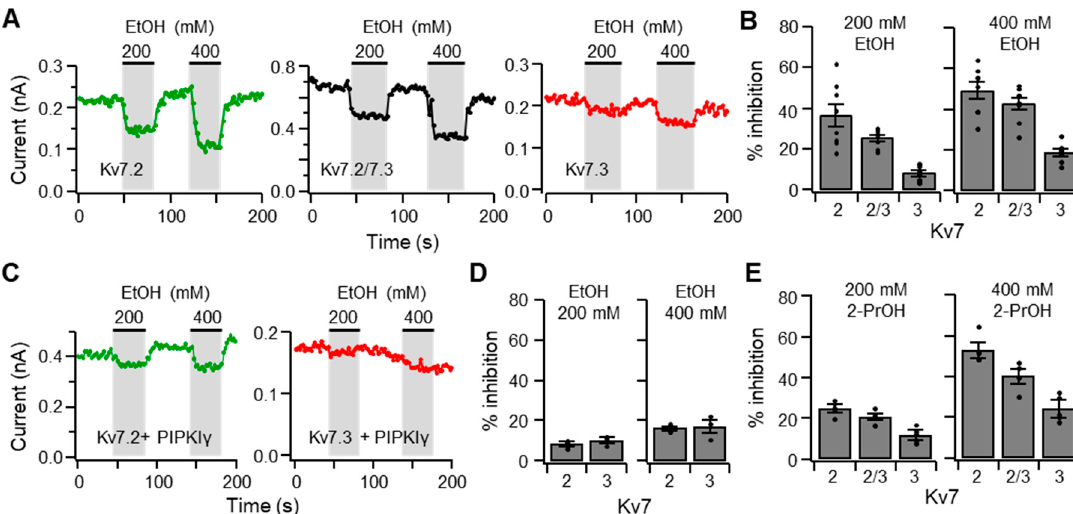
Figure 6. The inhibitory effect of ethanol is negatively correlated with the affinity of Kv7 subtypes to PI(4,5)P 2 . ( A ) Representative Kv7 currents exhibited by tsA201 cells transfected with Kv7.2 and Kv7.3 either individually or in combination. The currents were measured every 2 s in the presence of 200 and 400 mM ethanol for 40 s. ( B ) Percent inhibition of Kv7 currents in tsA201 cells incubated with ethanol ( n = 8 each). ( C ) Representative traces of tsA201 cells transfected with either Kv7.2 (green) or Kv7.3 (red) in combination with PIPKI γ . ( D ) Summary of Kv7 current inhibition in tsA201 transfected with either Kv7.2 or Kv7.3 in combination with PIPKI γ ( n = 3 each). ( E ) Percent inhibition of Kv7 currents in tsA201 cells upon treatment with 200 or 400 mM 2-propanol (2-PrOH, n = 5 each). Data are mean ± SEM.